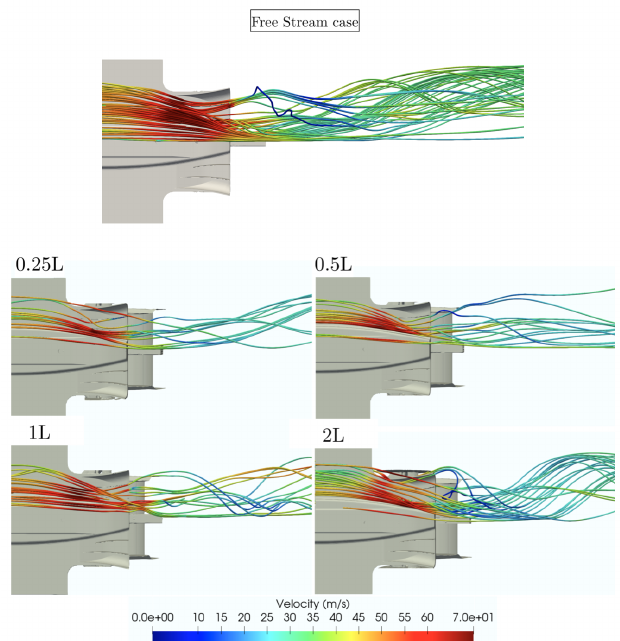
Figure 22. Streamlines of the velocity. Diffuser of the second car at a distance of 0.25 L, 0.5 L, 1 L, and 2 L as compared to the free stream